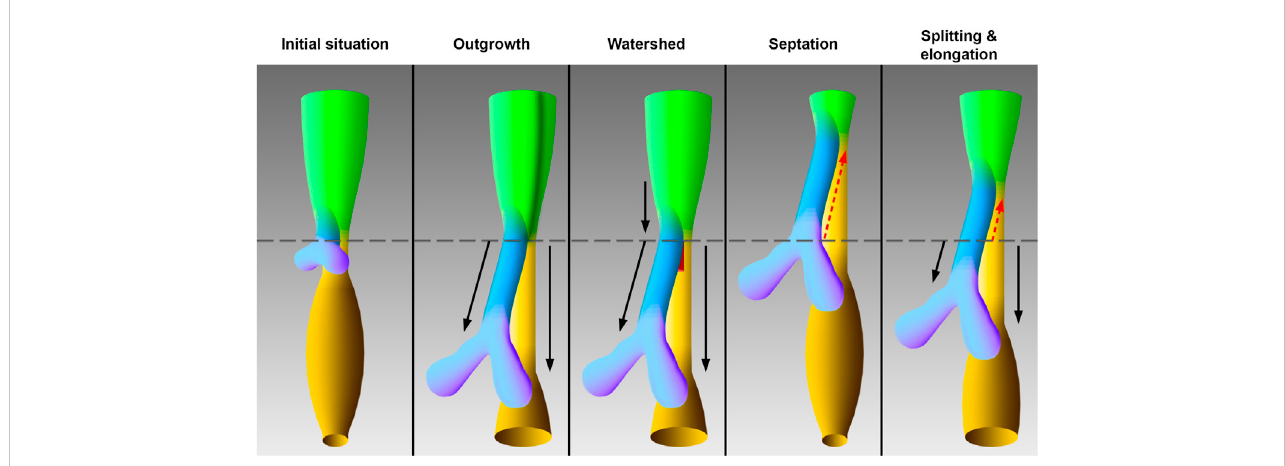
FIGURE 1 Models of tracheal development according to the original works. The initial situation of the early foregut shows lung buds without an apparent trachea, which corresponds to embryonic day 11 in rat embryos. The schematic drawings of the models correspond to embryonic day 12 in rat embryos. In the “ outgrowth ” model the trachea elongates from an area of the foregut, which differentiates later into the larynx (Zaw-Tun, 1982). A vertical dark green borderline indicate differentiation into larynx — hypopharynx in this foregut area. The “ watershed ” model postulates a mesenchymal “ wedge, ” which separates a descending foregut into trachea and esophagus (Sasaki et al., 2001). According to the “ septation ” model the common foregut is split from caudal to cranial by an evolving septum (Smith, 1957). In the “ splitting and elongation ” model the foregut is divided and the trachea and esophagus elongate (Que,